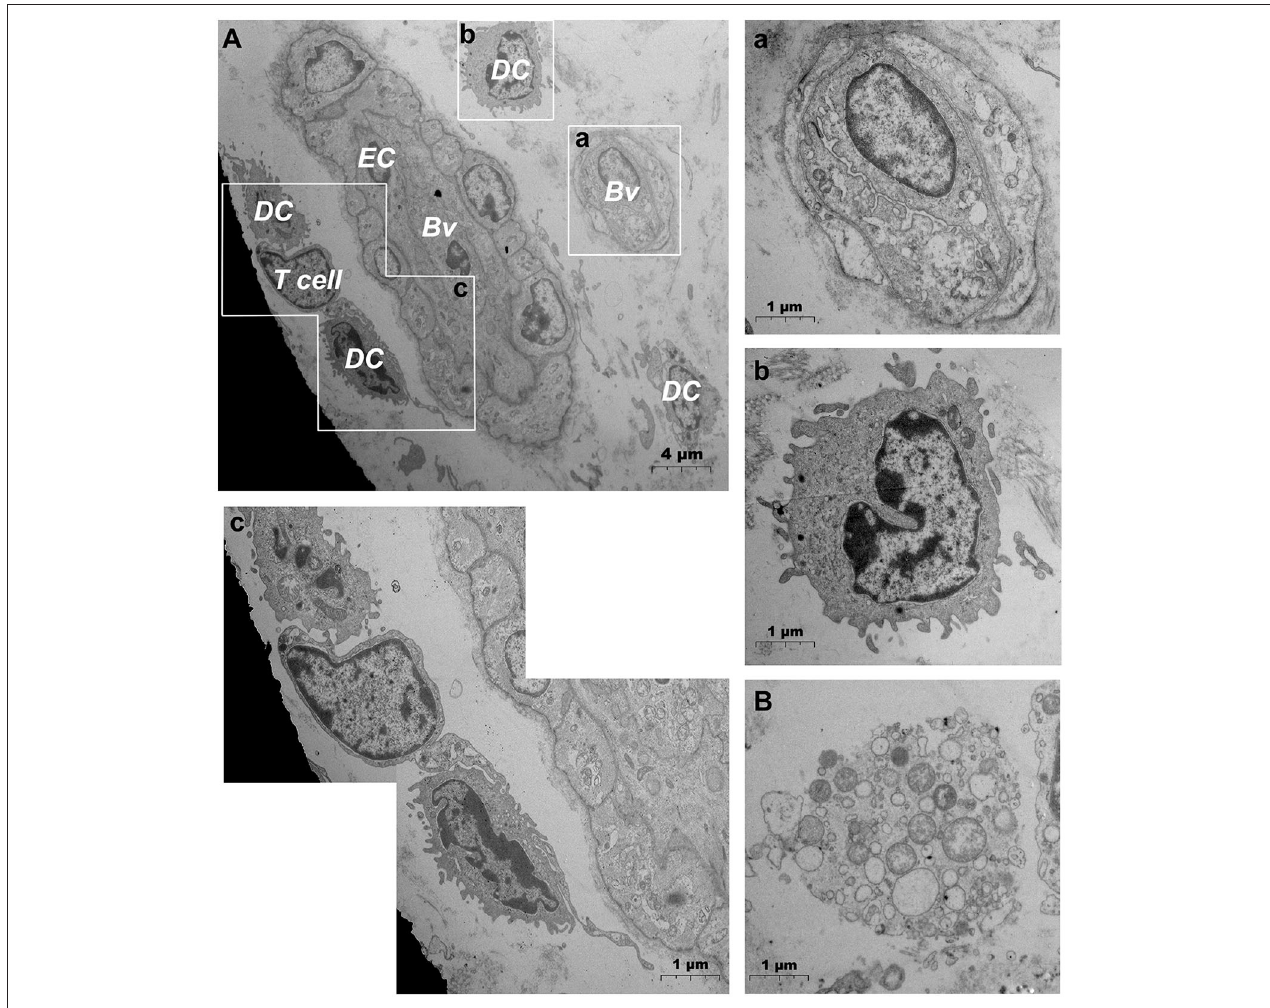
FIGURE 5 | Ultrastructural analysis of microvascular groups via TEM after jet needle-free injection. (A) Ultrastructure of microvessels and surrounding cells after jet needle-free injection; (a) is the enlargement of the capillarie in (A) ; (b) is the enlargement of the dendritic cell in (A) ; (c) is the enlargement of dendritic cells and the T cell in (A) ; (B) Macrophages that engulf carbon nanoparticles. Bv, blood vessel; EC, endothelial cell; DC, dendritic cell. The scale bar (A) = 4 µ m; (B) (a–c) = 1 µ